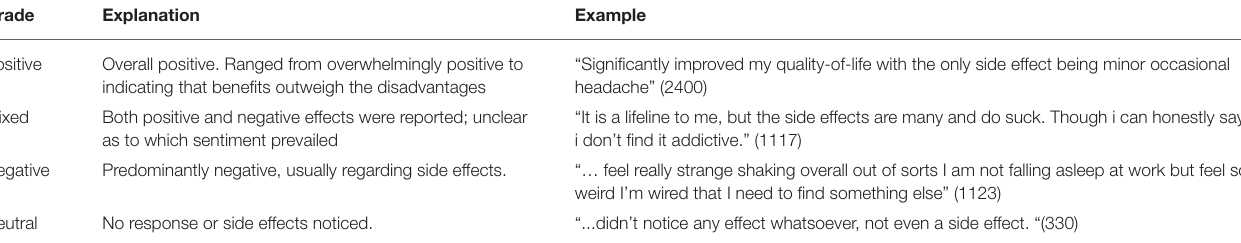
TABLE 2 | Examples of sentiment grading. Grade Explanation